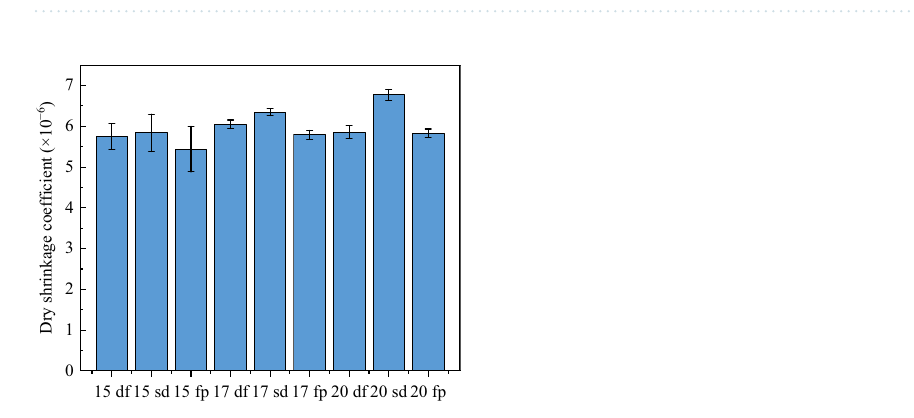
Figure 5. Dry shrinkage coefficient test setup of lime and fly ash-stabilized macadam.